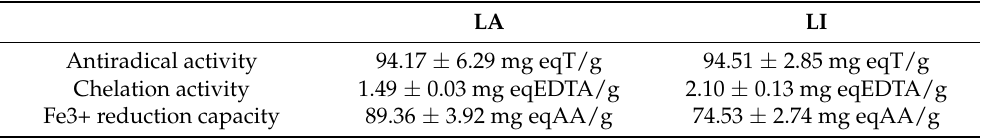
Table 3. Antioxidant activities of hydroalcoholic extracts of L. angustifolia and L. × intermedia expressed as the mean ± standard deviation milligrams of positive control per gram of lavender biomass. The results were obtained from three independent experiments on the replicates of the